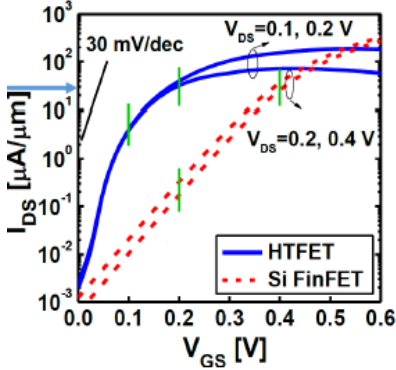
Figure 15. Drain-source current versus gate-source Figure 15. Drain ‐ source current versus gate ‐ source voltage.